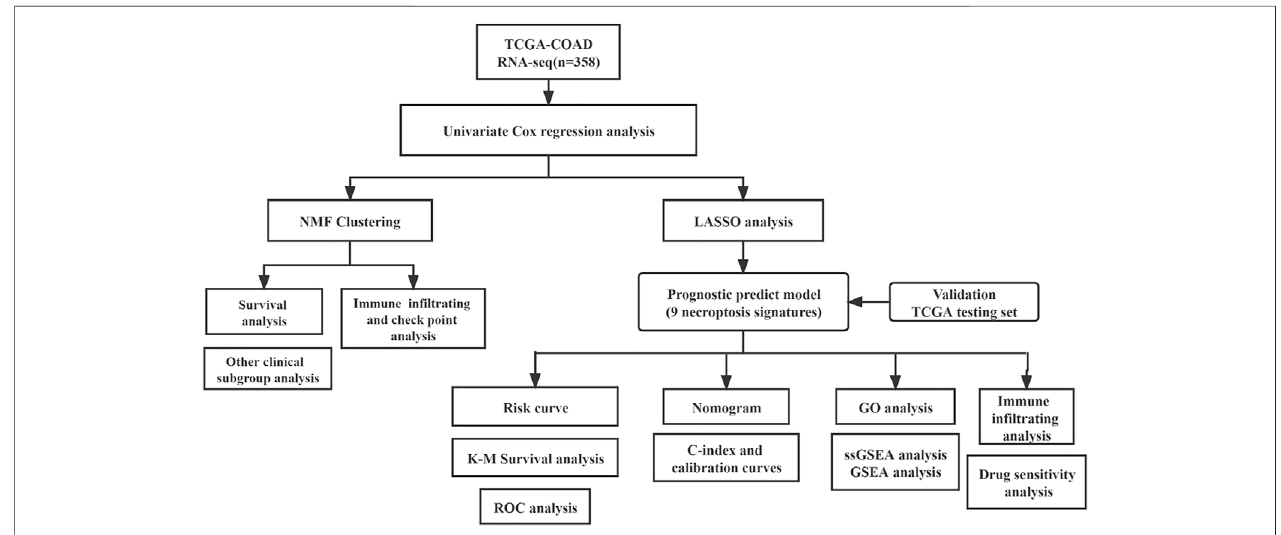
FIGURE 1 | Flowchart for pro fi ling the necroptosis-related genes of colorectal cancer.